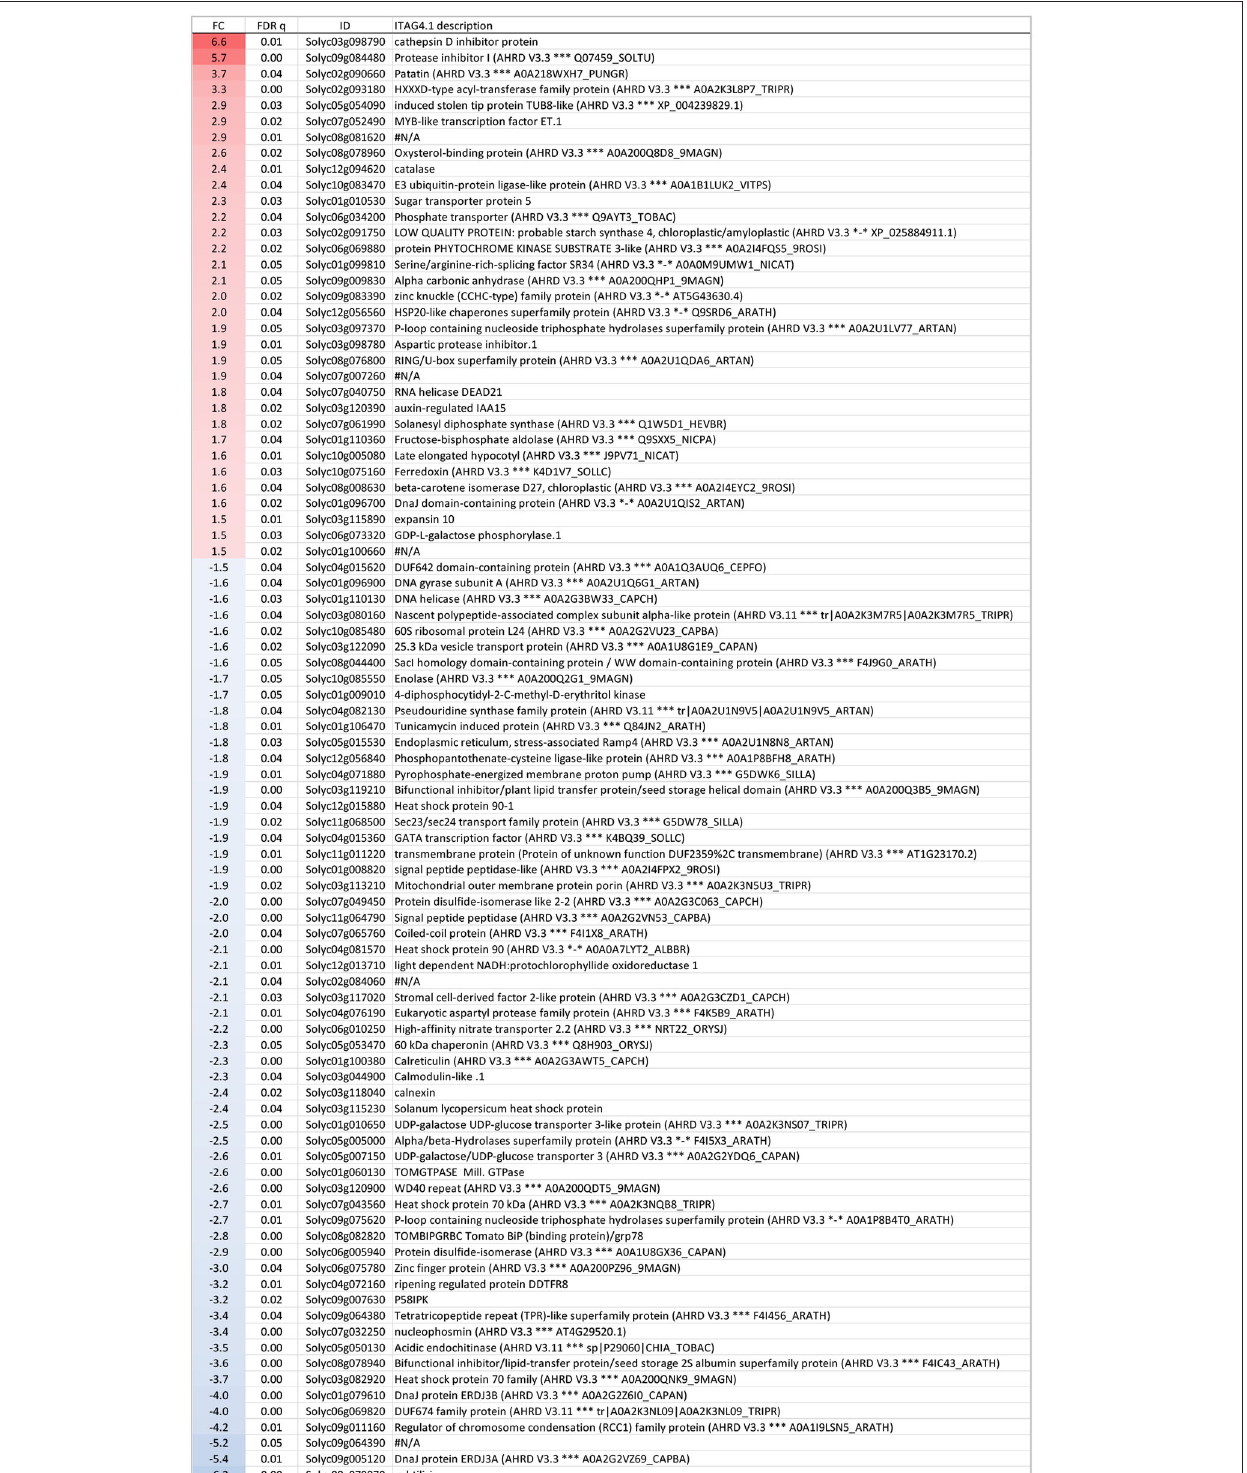
Frontiers in Plant Science |